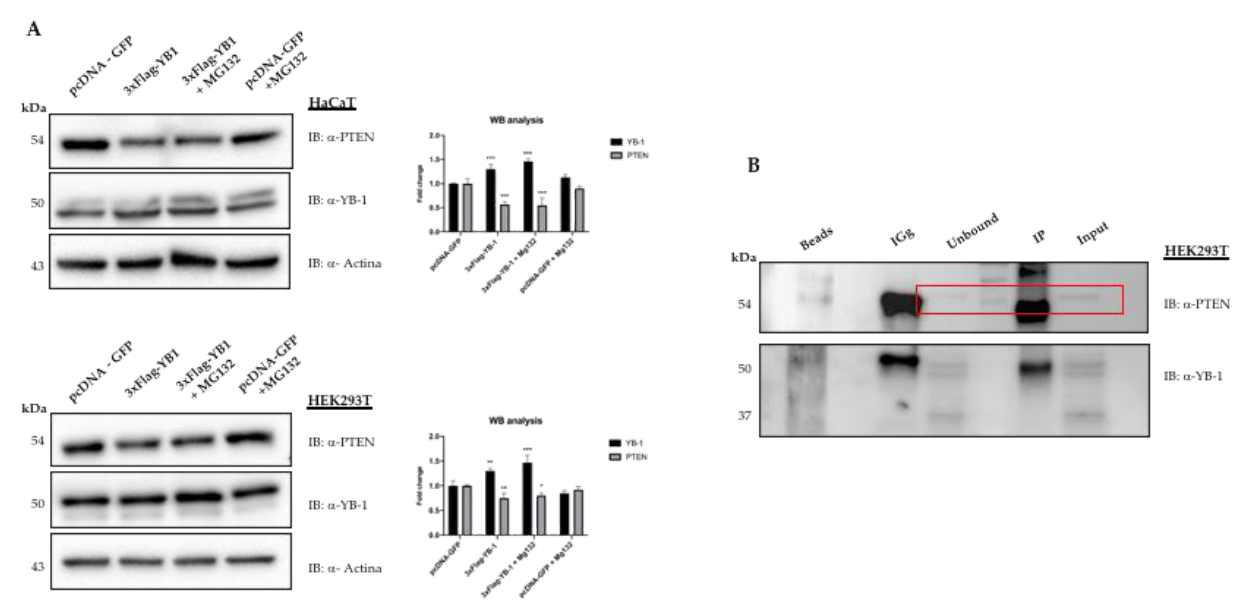
Figure 3. YB-1 mediated reduction of PTEN levels requires neither the proteasomal activity nor the physical interaction between the two proteins. ( A ) HaCaT cells (top panel) and HEK293T cells (lower panel) were transfected with 3XFlag-YB- 1 plasmid or pcDNA-GFP as a control. Effect on PTEN intracellular levels was evaluated 48hrs post-transfection by west- ern blot on whole protein lysates probed with anti-YB-1, anti-PTEN, and anti-actin as a loading control. 10 μ M MG132 for 4h before the end of transfection was used to inhibit proteasome activity. ( B ) HEK293T protein extracts were immunopre- cipitated with anti-YB-1 antibodies. Immunocomplexes were subjected to western blot and revealed using antibodies against PTEN. PTEN signal in unbound and input are highlighted in the rectangle box. Statistical analysis was performed using 2- way ANOVA and Sidak’s multiple comparison test. Levels of significance between points of expression are indi- cated (*** p < 0.001, ** p < 0.01, * p < 0.05).